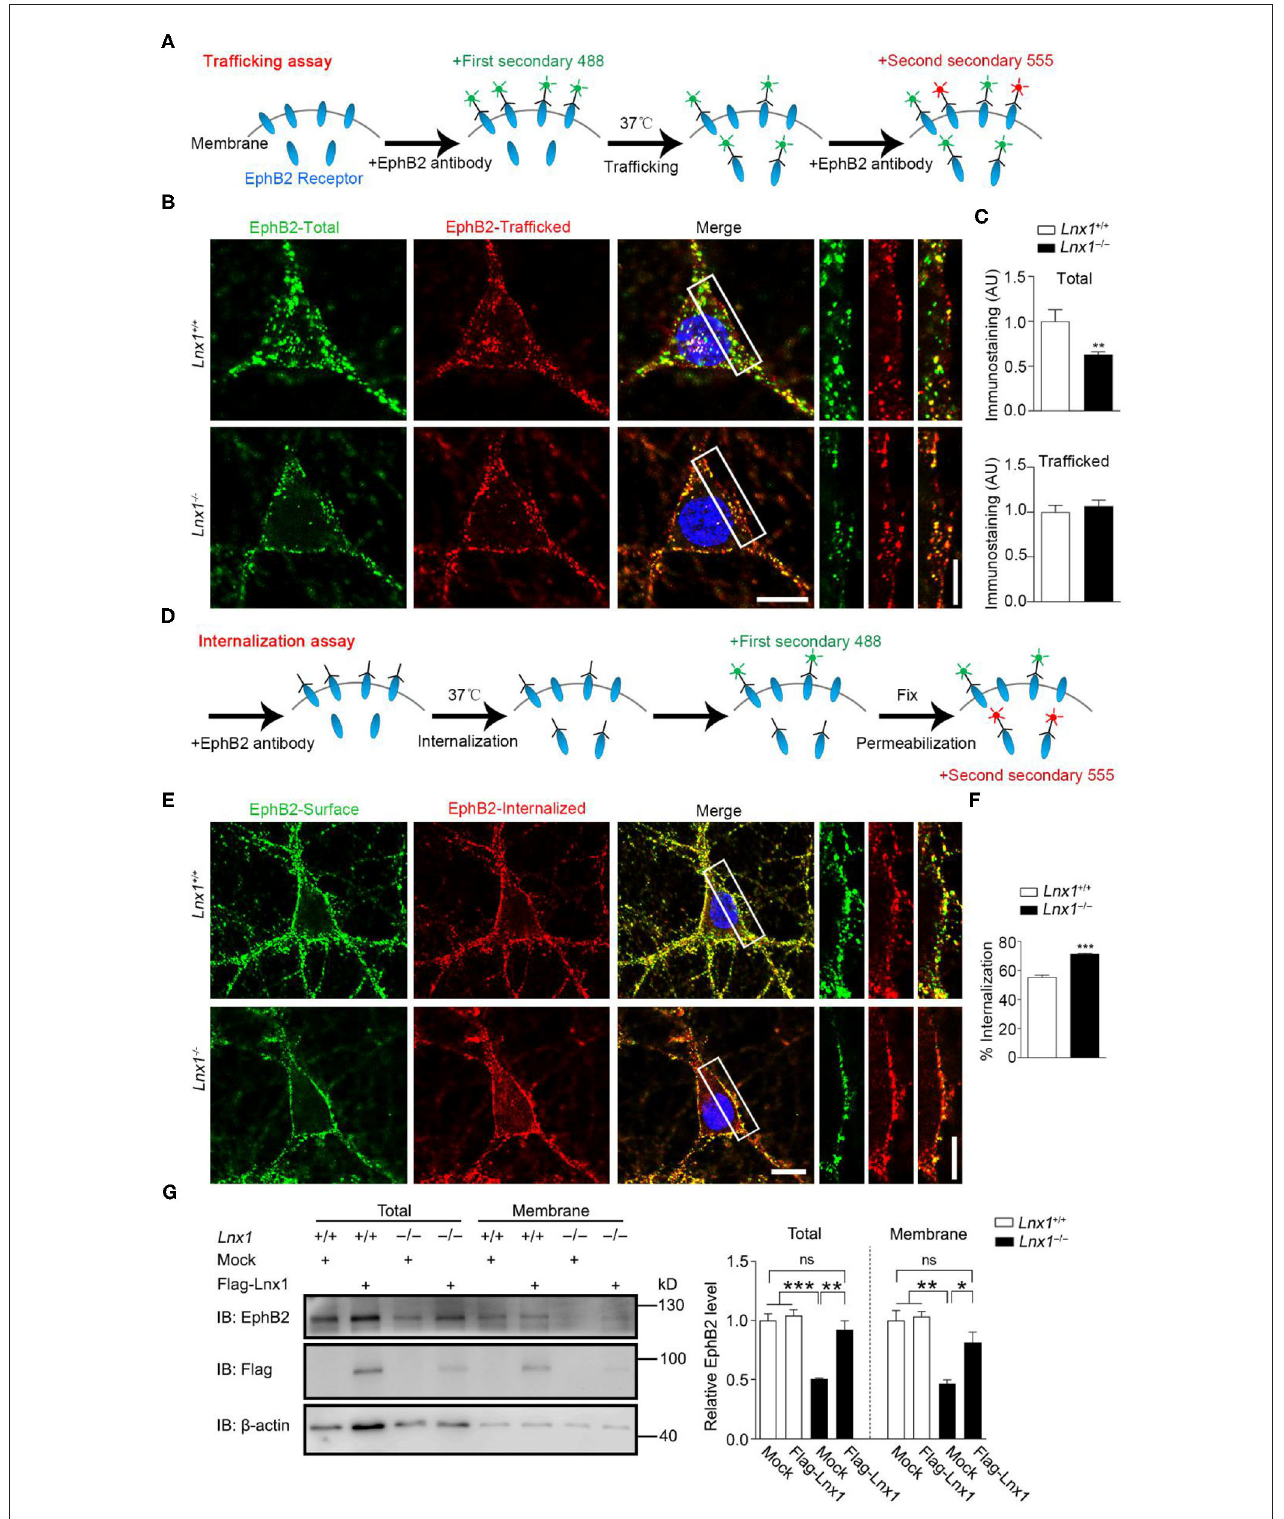
FIGURE 3 | Ligand of Numb protein X 1 (Lnx1) knockout affects the internalization of EphB2 receptors. (A) Schematic diagram shows the strategy to label the trafficking of EphB2 receptors. (B) Trafficking of EphB2 receptors in Lnx1 + / + and Lnx1 − / − hippocampal neurons. Green, total membranous EphB2 receptors; red, newly trafficked EphB2 receptors. Scale bars represent 10 µ m (left) and 5 µ m (right). (C) Statistical analysis of total and trafficked EphB2 receptors. n = 20 neurons